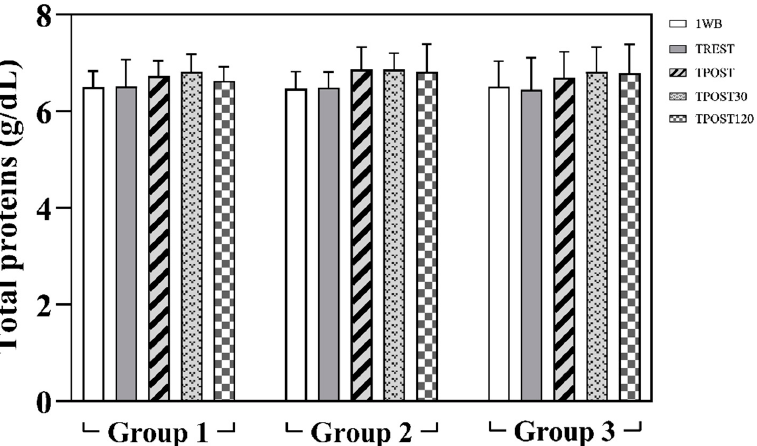
Figure 4. Mean values ± standard deviation ( ± SD) of serum total proteins measured 1 week prior to the race (1WB), the day of the race at rest (TREST), immediately after the race (TPOST), and after 30 (TPOST30) and 120 min (TPOST120) in Thoroughbred racehorses belonging to Group 1 (1200 m race), Group 2 (1600 m race) and Group 3 (2000 m race). Table 2. Coefficients of correlation between the serum values of reactive oxygen metabolites (dROMs) and the levels of thiol antioxidant barrier (SHp) and antioxidant barrier (Oxy-ads), homo- cysteine (Hcy), creatine kinase (CK), lactate dehydrogenase (LDH) and aspartate aminotransferase (AST) obtained from racehorses competing in official races of 1200 (Group 1), 1600 (Group 2) and 2000 m (Group 3). Blood samples were collected from each horse 1 week prior to the race (1WB), the day of the race at rest (TREST), immediately after the race (TPOST), and after 30 (TPOST30) and 120 min (TPOST120). p -values < 0.05 were considered statistically significant. Parameters GROUP 1